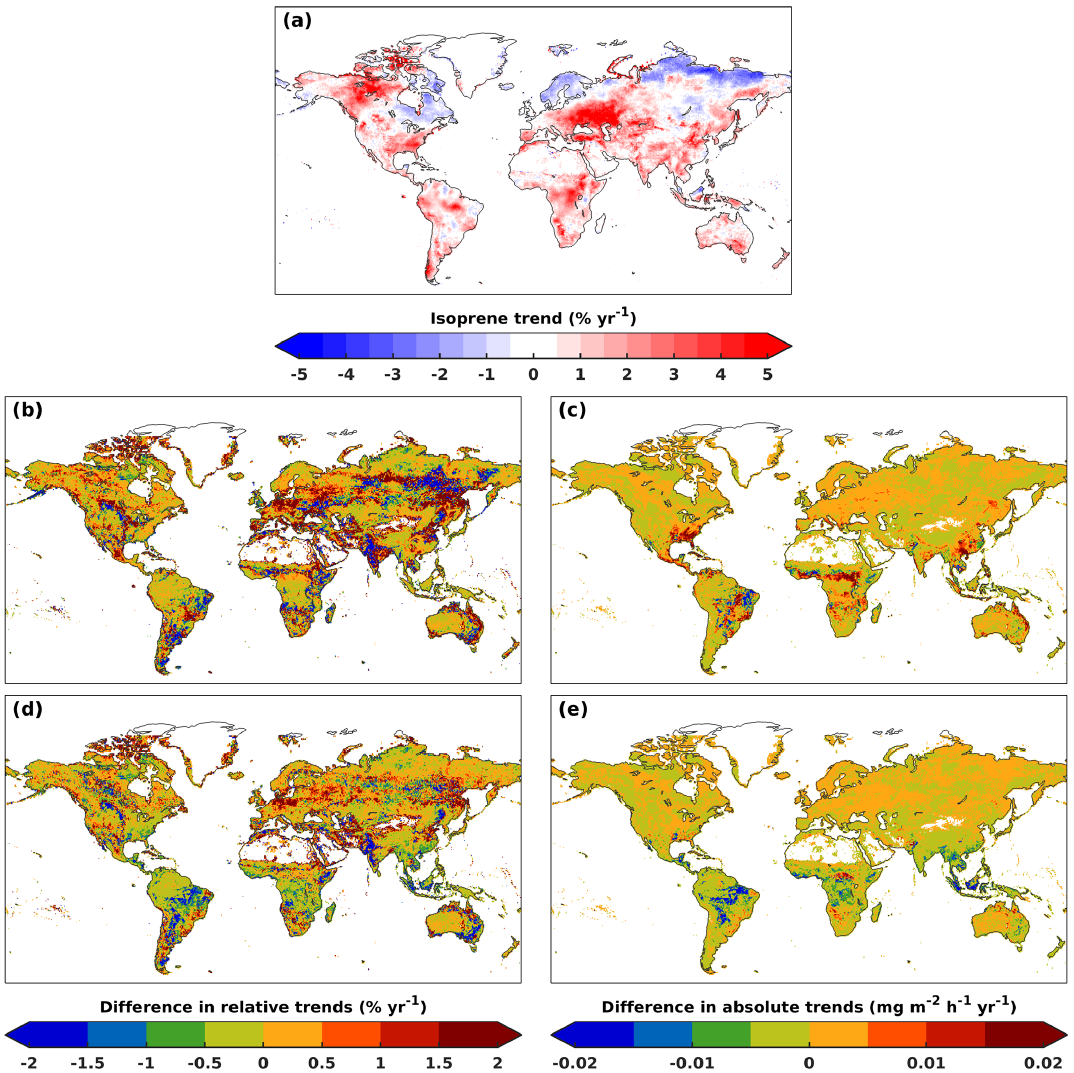
Figure 7. Global distribution of annual isoprene emission trends for the 2001–2016 period. Panel (a) displays the relative trend (%yr − 1 ) in the CTRL run. The relative trend differences between the runs are shown in (b) ISOPMOD-CTRL and (d) ISOPGFW-CTRL. The absolute trend differences (in mgm − 2 h − 1 yr − 1 ) are shown in (c) ISOPMOD-CTRL and (e) ISOPGFW-CTRL. Table 6. Annual isoprene emission estimates (in Tg) averaged over 2001–2016 in largely forested countries and isoprene trends over 2001– 2016 (in %yr − 1 ). In the CTRL study, isoprene trends pertain to changes in meteorological conditions. The combined effect accounting for both meteorological and LULC trends is given for ISOPMOD and ISOPGFW, while the effect from LULC changes is provided in